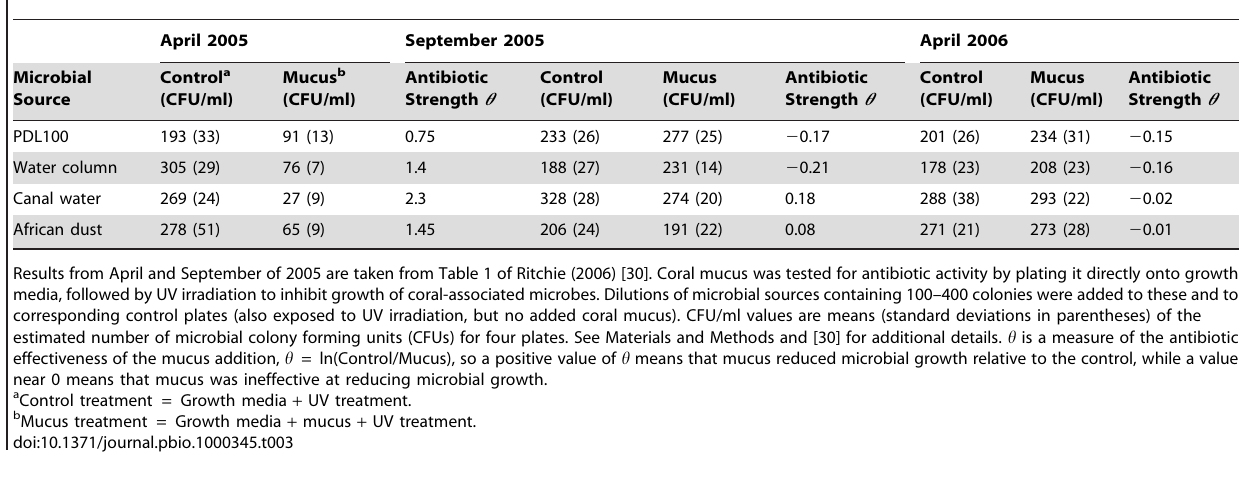
Table 3. Microbial inhibition by Acropora palmata